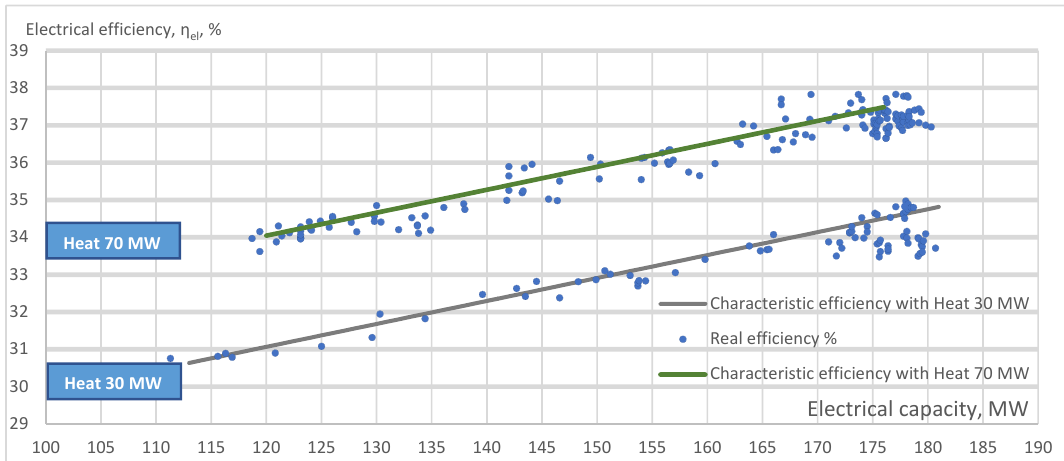
Figure 8. Electrical efficiency of the unit for heat load 30 MW and 70